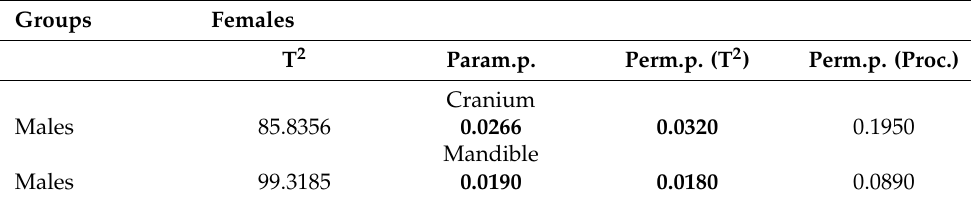
Table 8. DFA results for cranial and mandibular data between vole sexes (T 2 : T-square, Param. P: parametric p values, Perm. P: permutation p value, Proc.: Procrustes distance value, boldfaced: a significant